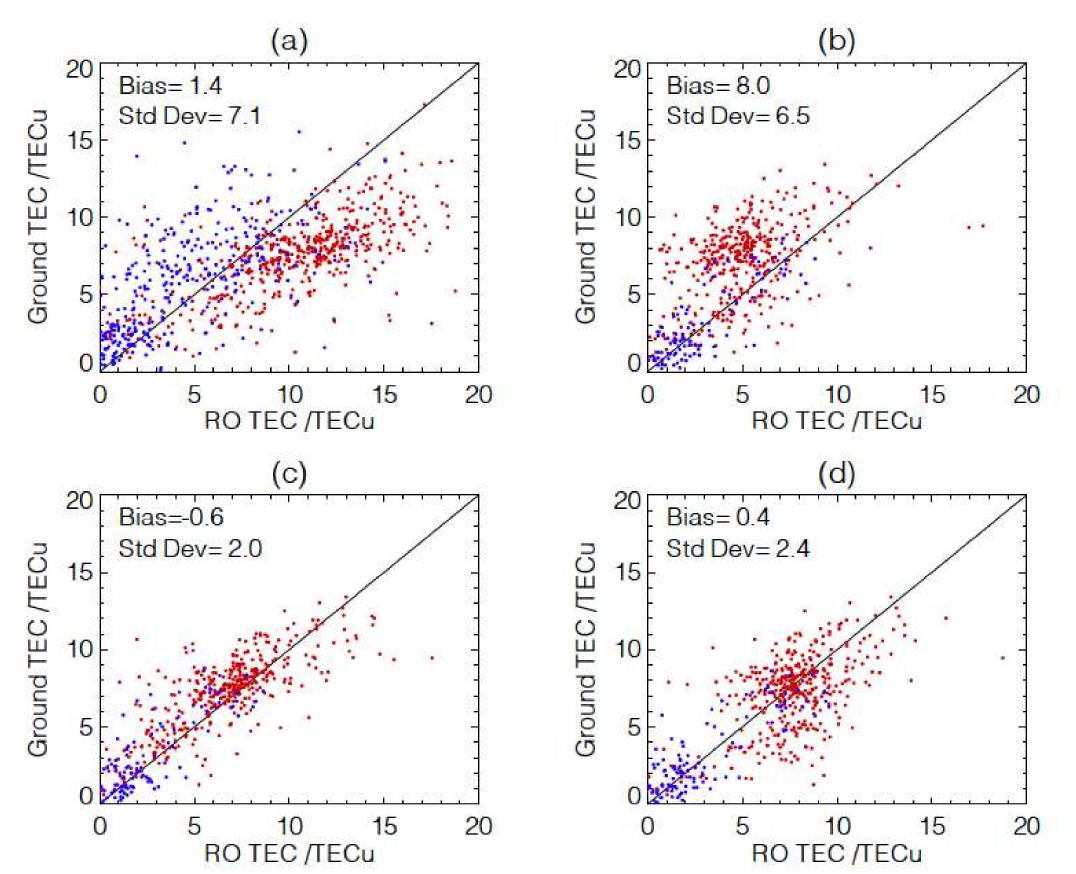
Figure 18. ( a – d ) RO- TEC retrievals using the methods as labeled for the same panels as in Figure 7 and Equations (11) and (12), and their comparison with Ground- TEC . The MetOp-A RO data from 9–18 June 2020 are used because its high-rate ROs had a top up to h t ~ 290 km. The 1:1 line is plotted to guide the comparisons where daytime and nighttime measurements are in red and blue,